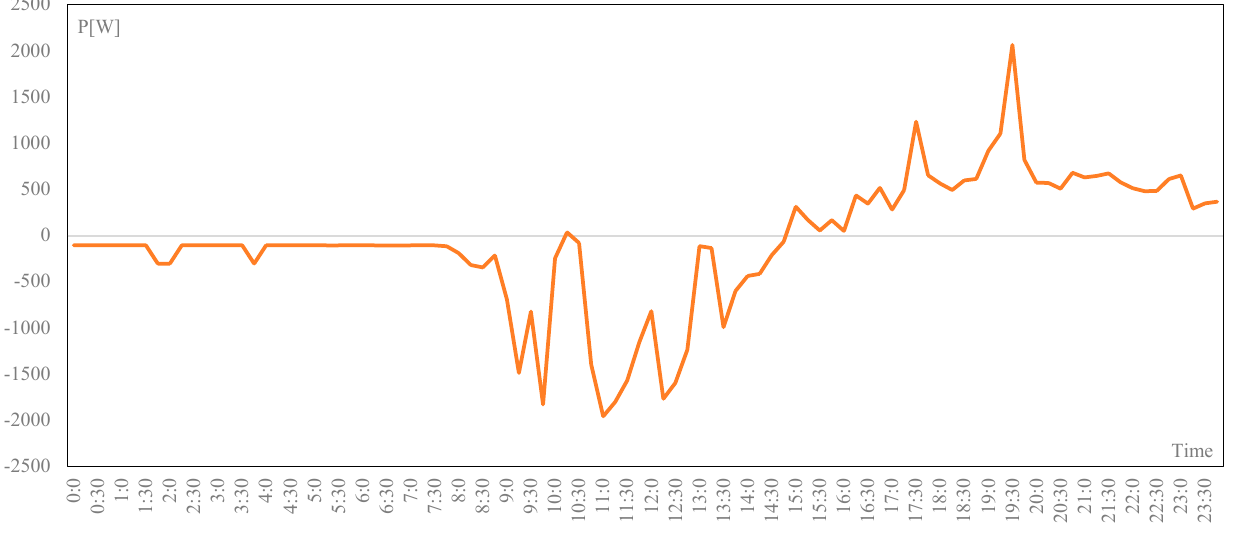
Figure 17. Exchanged grid net power with flexibility service.